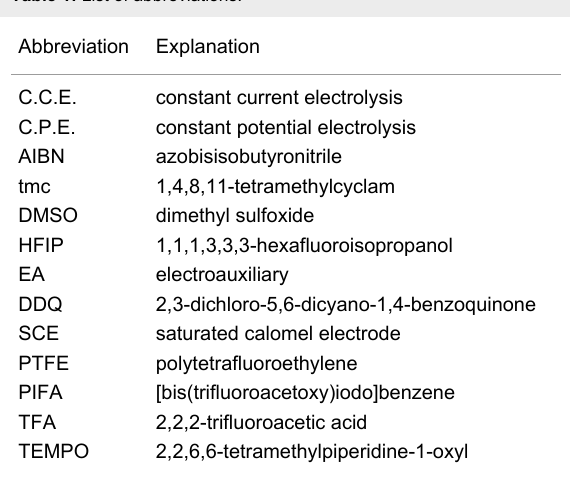
Table 1: List of